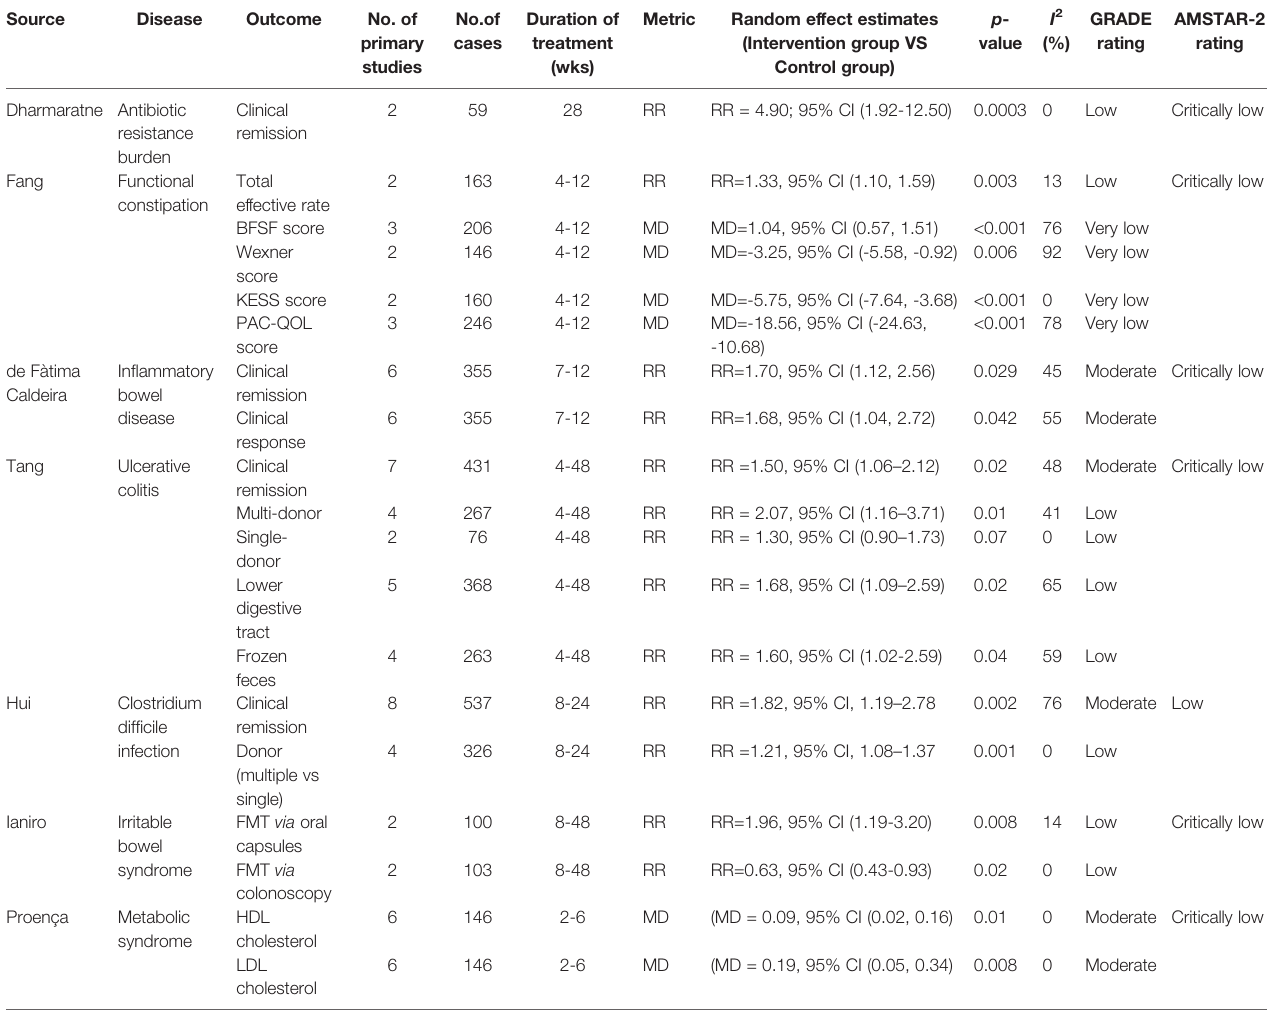
TABLE 3 | Summary of signi fi cant associations of fecal microbiota transplantation with health